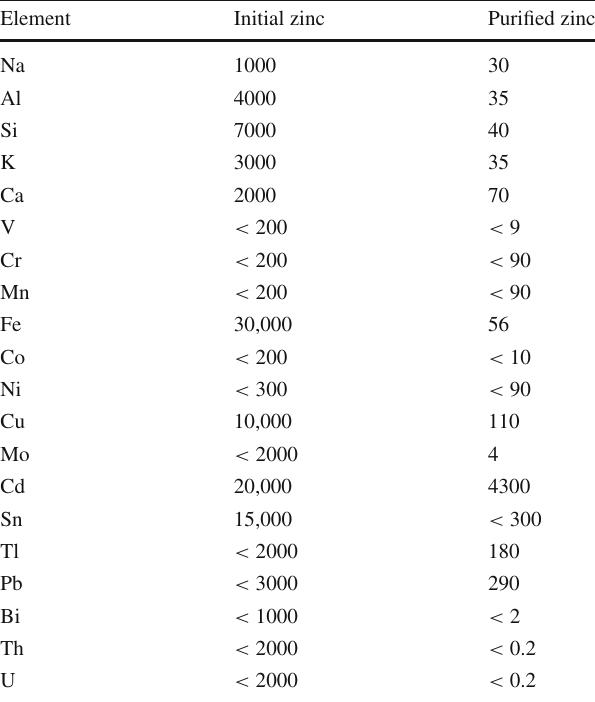
Table 1 Impurity concentration in the zinc before and after the purifi- cation process in ppb (10 − 9 g/g) with uncertainties of 25% Element Initial zinc Purified